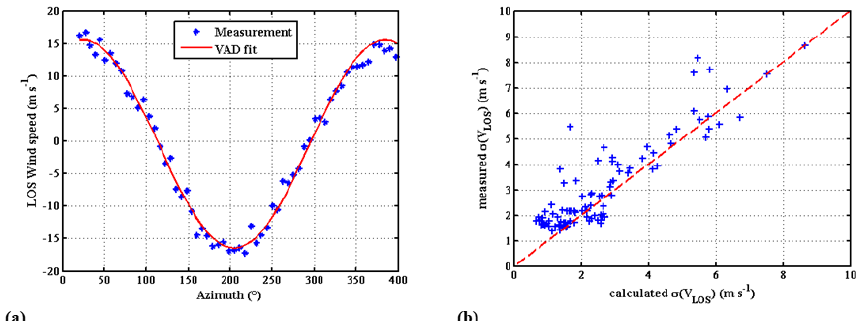
Figure C1. (a) LOS wind speed retrieved by HSRD-LNG over 100 shots at an altitude of 7.9km. (b) Comparison of the measured and calculated LOS wind speed ( V LOS ) errors.